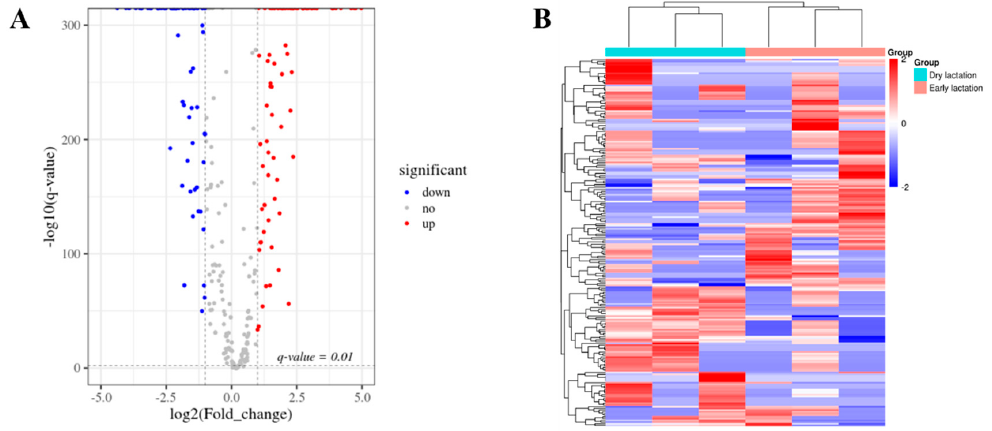
Figure 2. Differential expression of circRNAs in the goat mammary gland during early lactation and dry lactation. ( A ) Volcano plot of circRNAs expressed differently between early lactation and dry lactation; ( B ) heatmap of circRNAs expressed differently between early lactation and dry lactation.